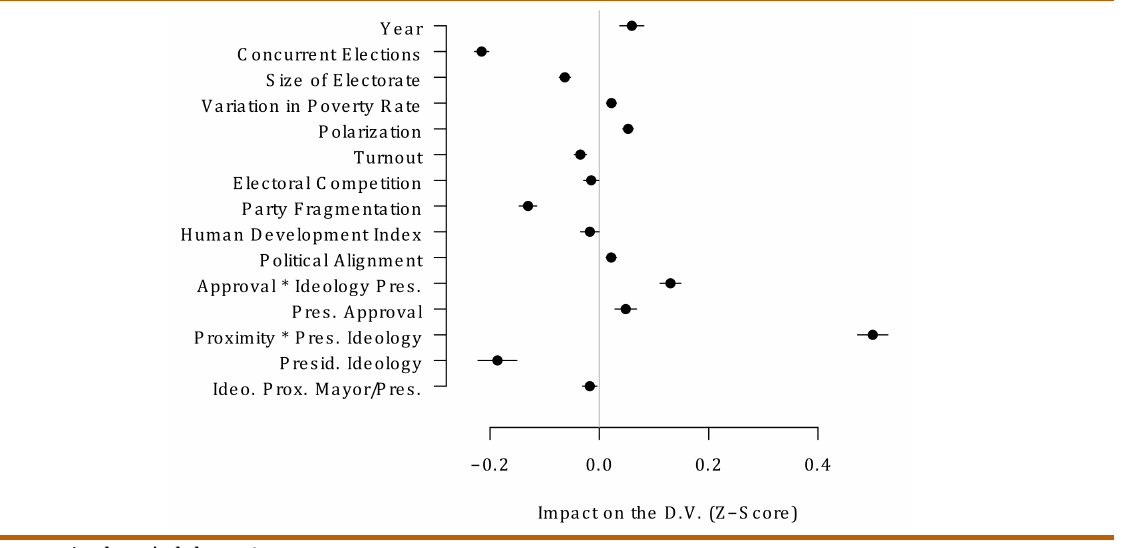
Figure 5: Changes in the MIS (GLS pooled model coef(cid:976)icients)